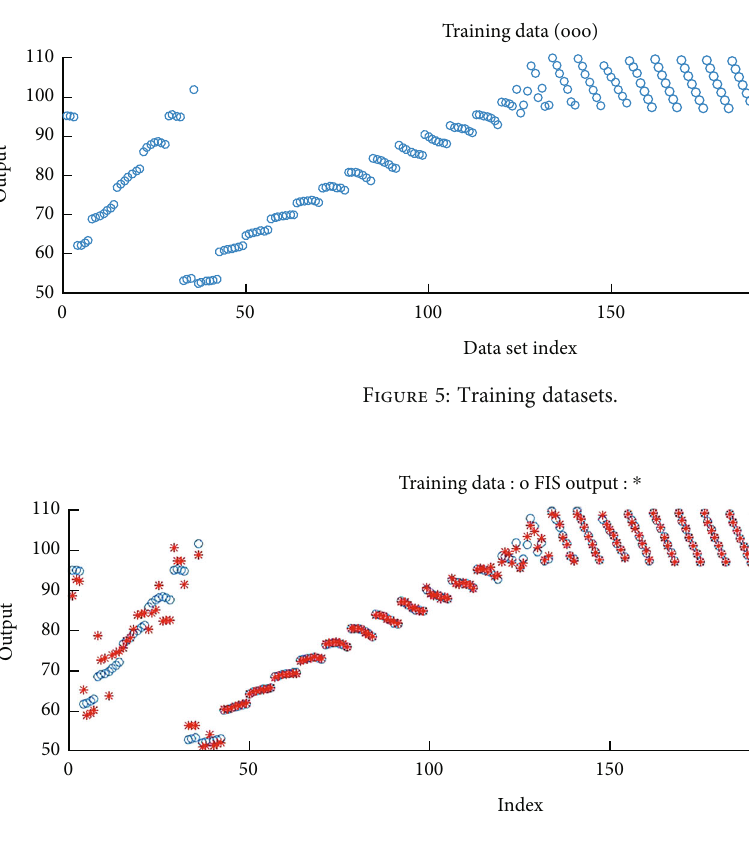
Figure 6: Training output.